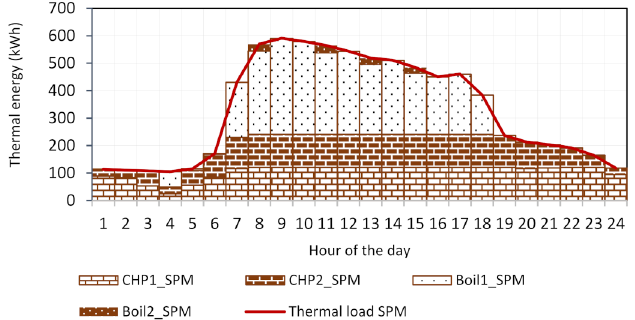
Figure 21. Thermal energy balance of the SPM for space heating and domestic hot water obtained with stochastic economic optimization for the representative winter